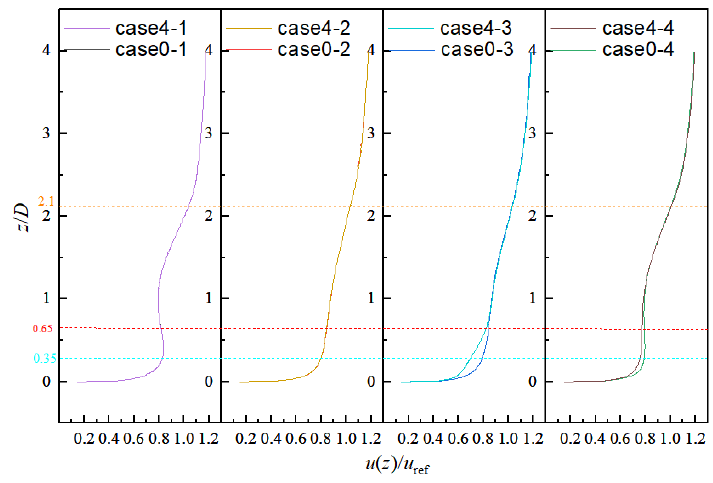
Figure 7. Comparison of vertical velocity wind profiles of Case 4 and Case 0.